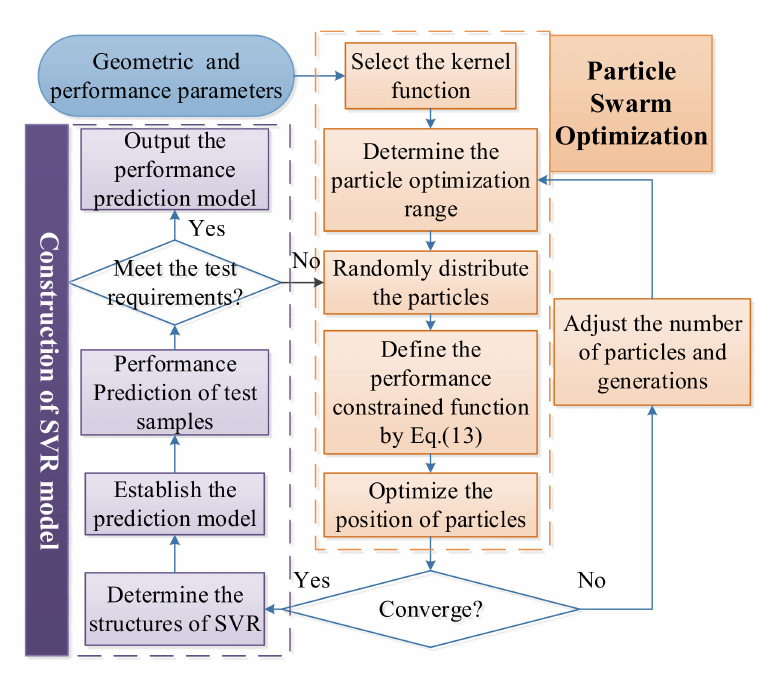
Figure 4. Construction Process of PSO-SVR